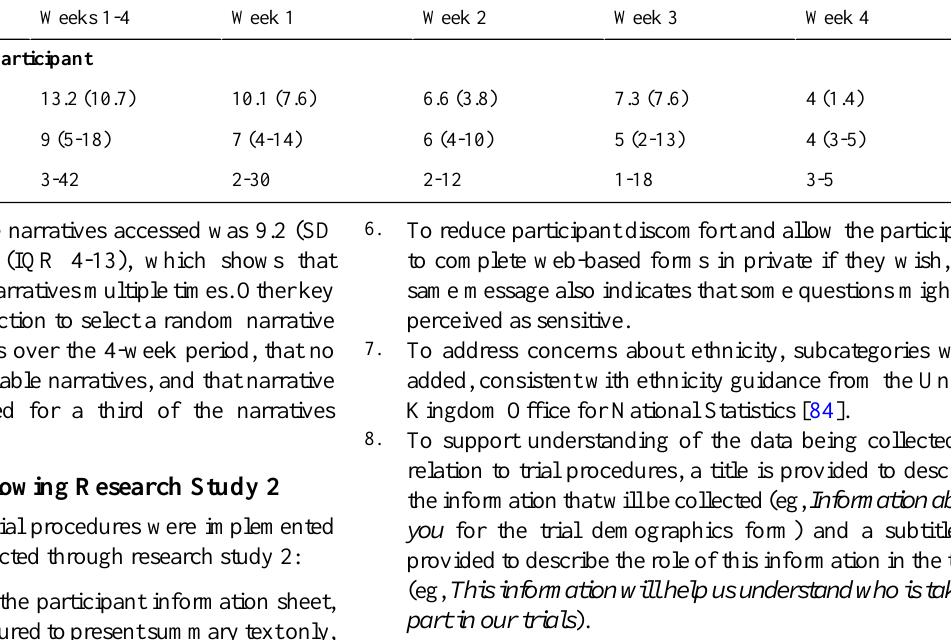
Table 4. Narrative accesses calculated from logged data about prototype usage by participants